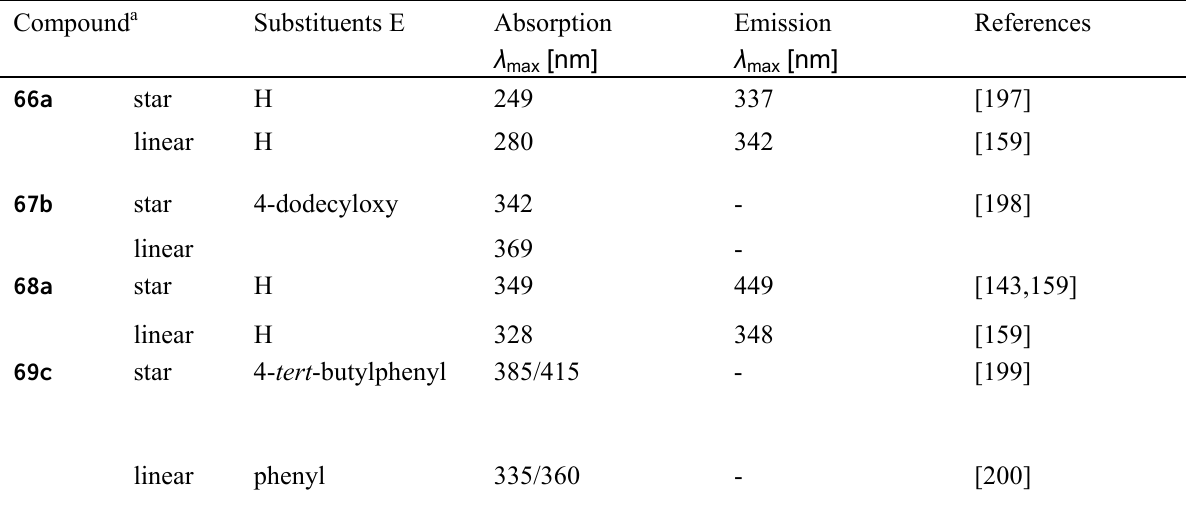
Table 5. Photophysical properties of hexaarm